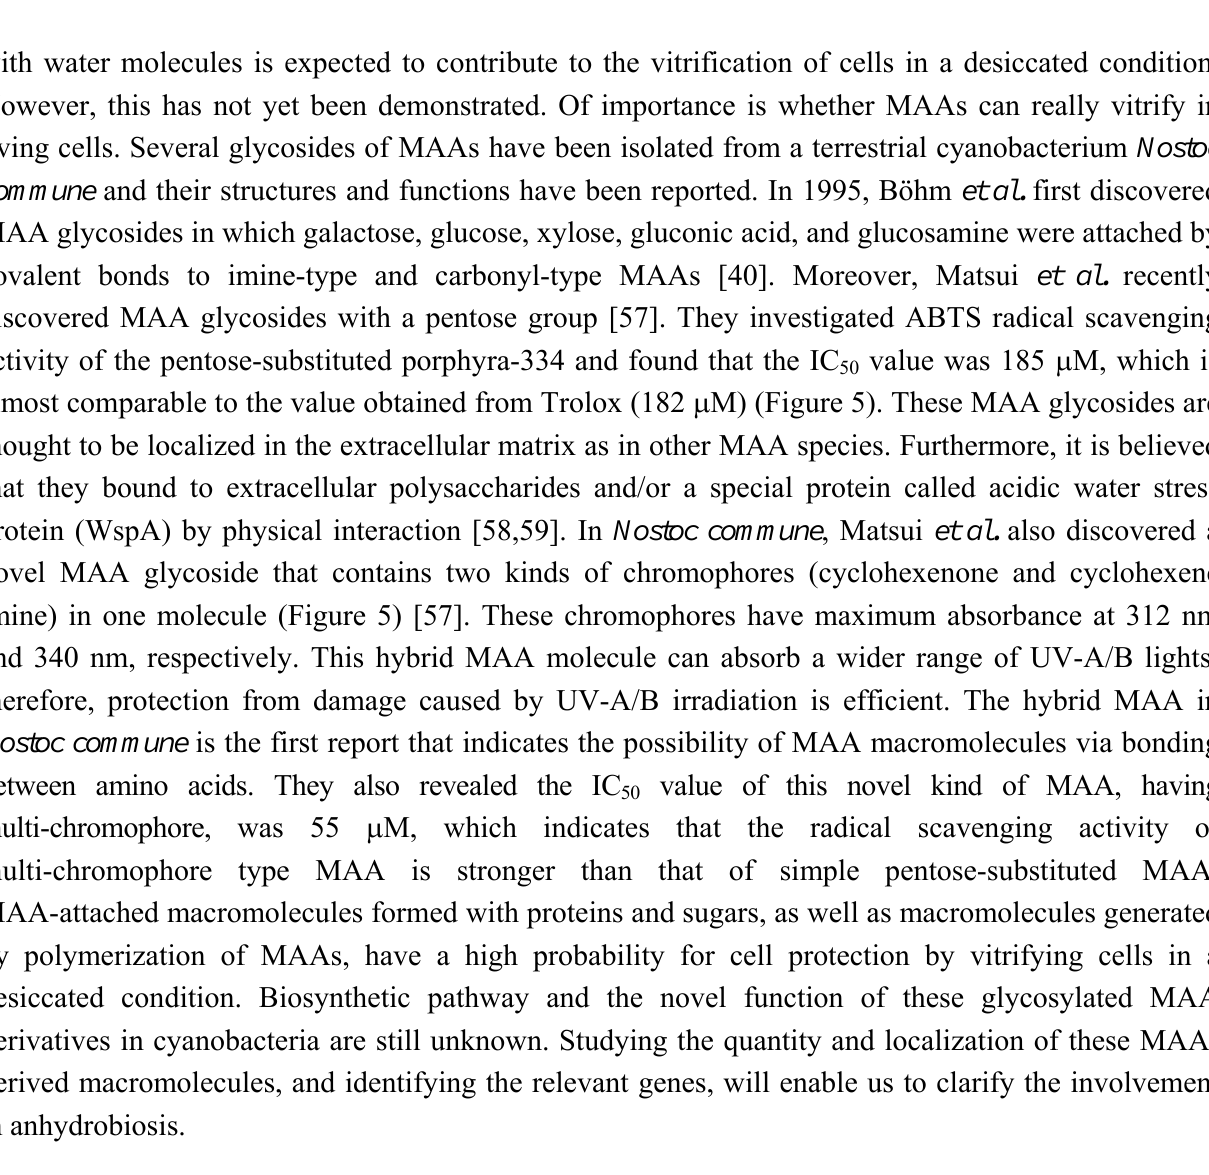
Figure 5. The novel glycosylated MAAs in Nostoc commune and their ABTS radical ) scavenging activities (IC 50